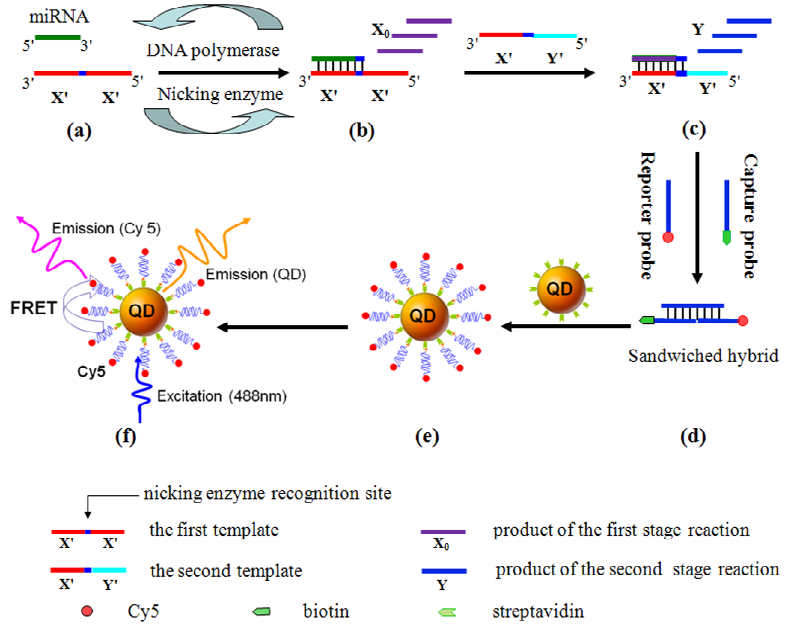
Figure 5. Scheme of the miRNA assay based on the two-stage EXPAR and single-QD-based nanosensor. Reprinted with permission from [44]. Copyright 2012 American Chemical